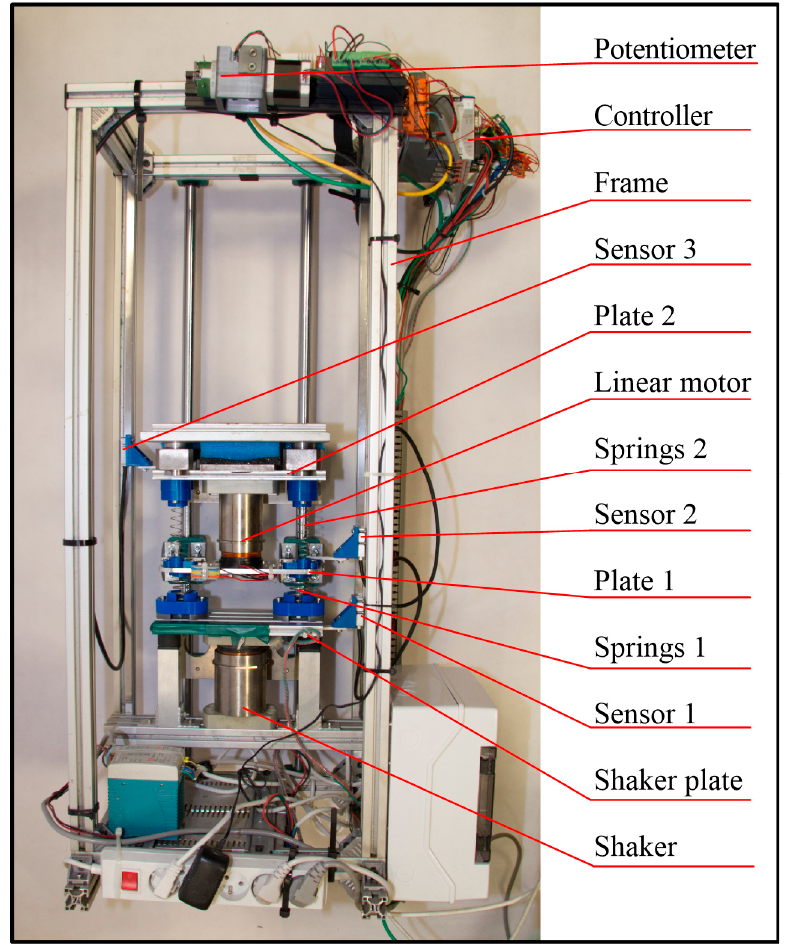
Figure 11. Test rig.